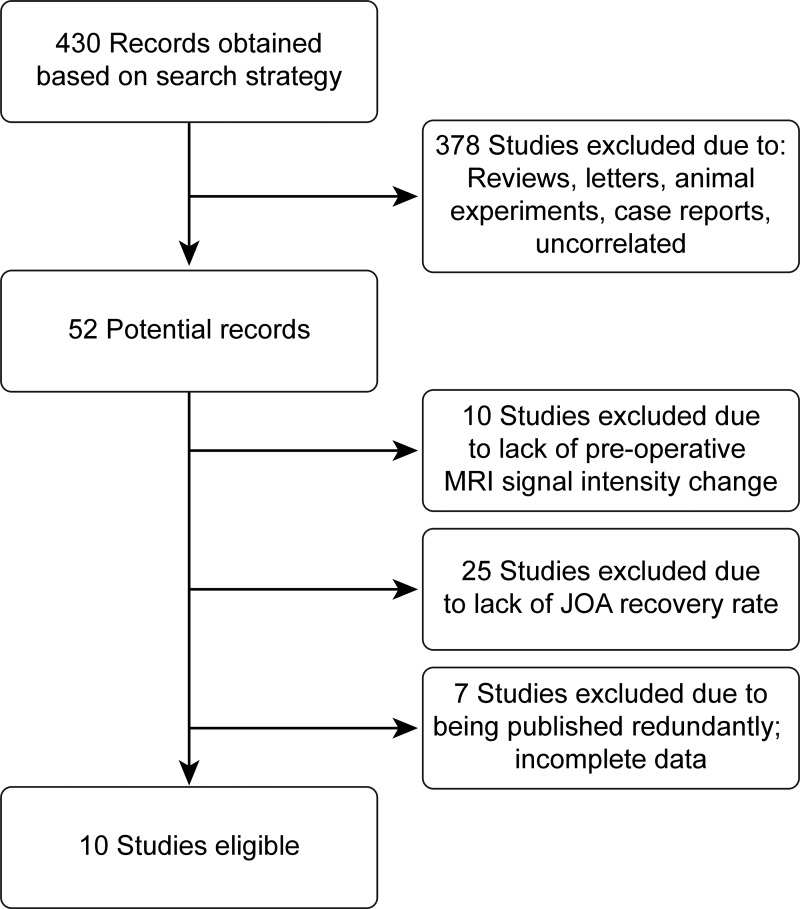
The search strategy.